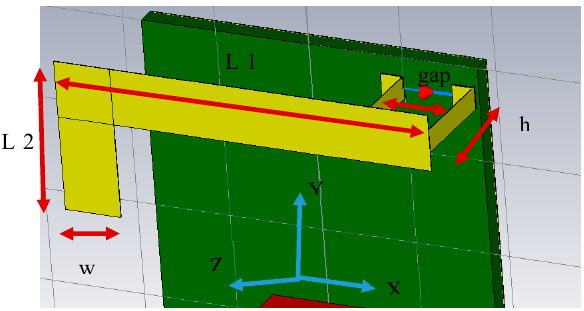
Figure 5. Simulation model of IFA for the RF module.